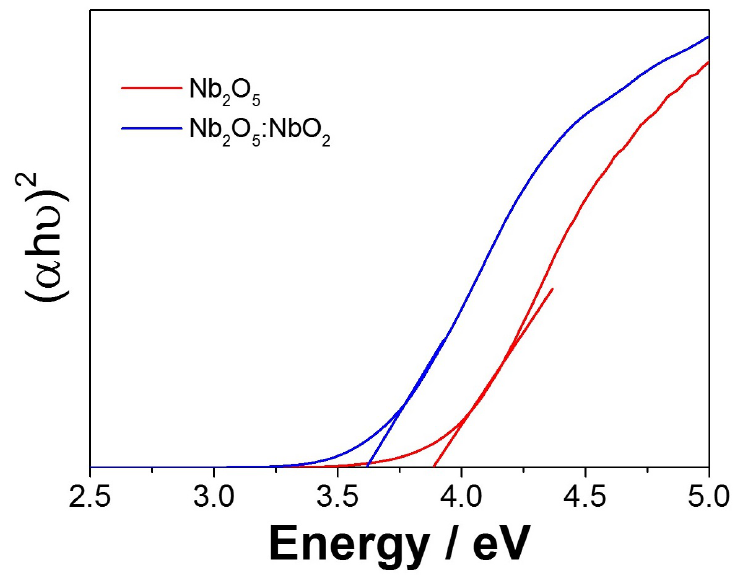
Figure 5. Diffuse reflectance spectroscopy (DRS) of fibers annealed at 600 ◦ C for 2 h, with heating rates of 1 and 10 ◦ C min − 1